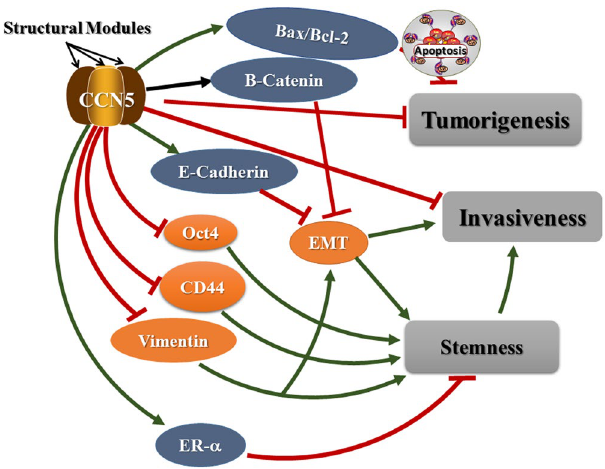
Figure 9. Diagram illustrating CCN5 regulation of molecular markers associated with cell growth, EMT and stemness in TNBC cells. Blue indicates upregulated proteins and orange indicates downregulated proteins. Individual figures were obtained from ScientificSlides suite, a Microsoft PowerPoint based